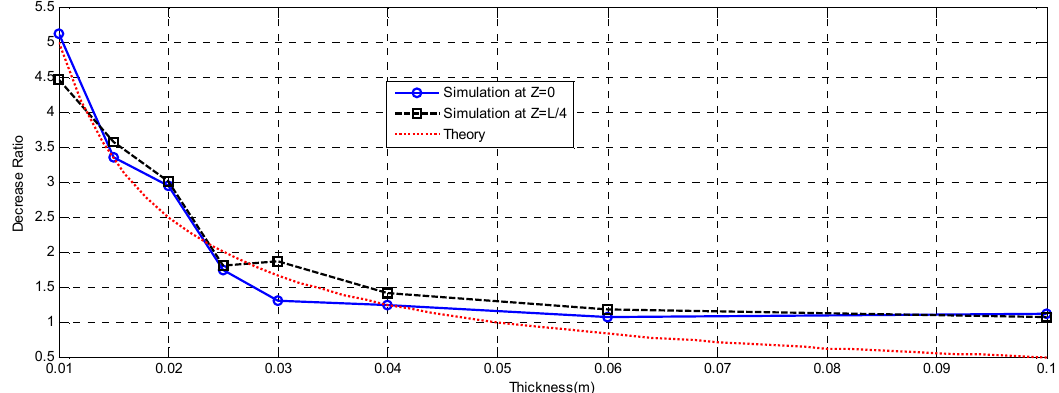
Figure 30. The comparison of decreasing ratio in the conditions of Z = 0, Z = L /4 and theory.